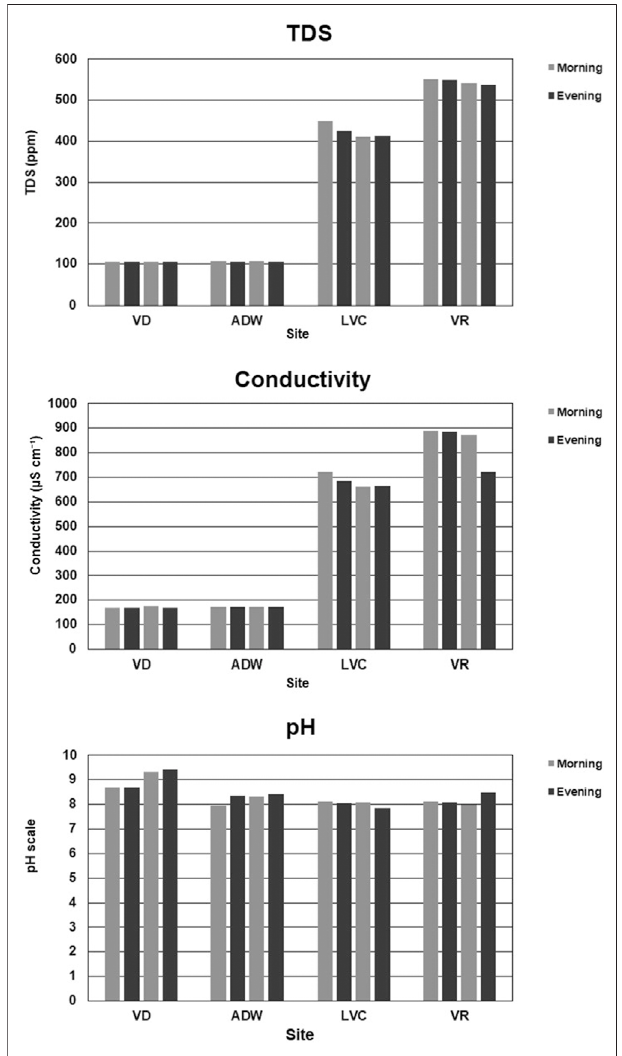
FIGURE 2 | Bar graphs of water quality parameter Total Dissolved Solids-TDS(ppm), Conductivity( μ s.cm − 1 ) and pHinthe morningand evening on the days